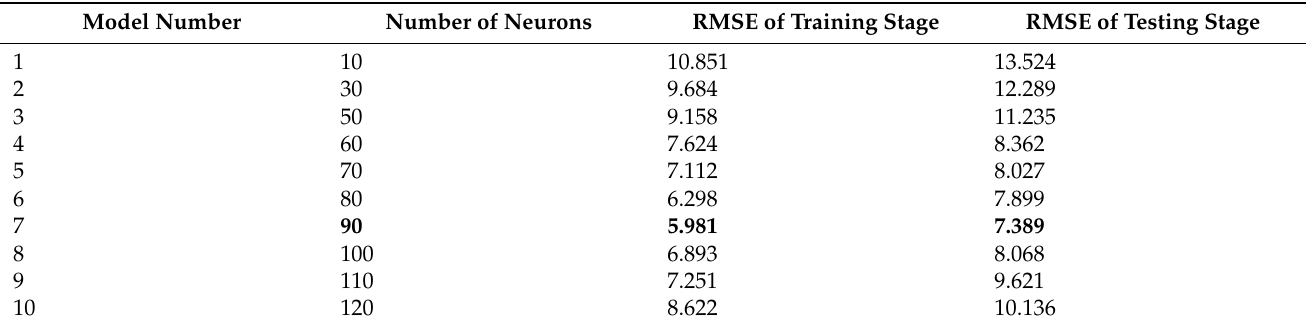
Table 2. Outcomes of the trial-and-error process used to determine the number of neurons in the ELM